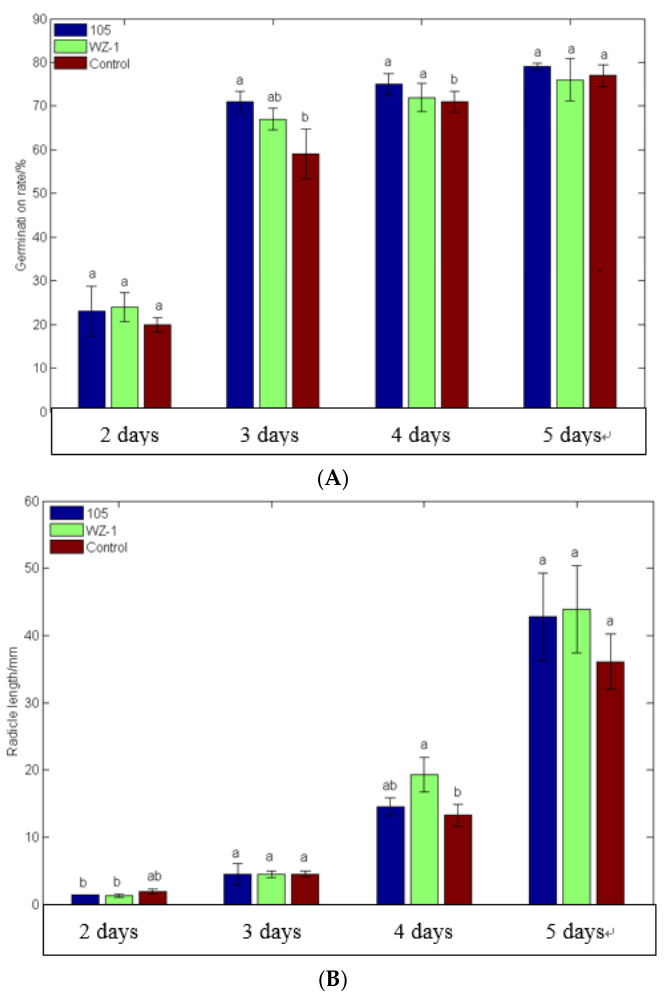
Figure 6. Effects of the strain WXCDD105, the strain WZ-1 and the water control on seed germination ( A ) and radicle growth ( B ) of tomato. The different normal letters in the same point indicate significant difference among treatments at 0.05 level ( n = 3).